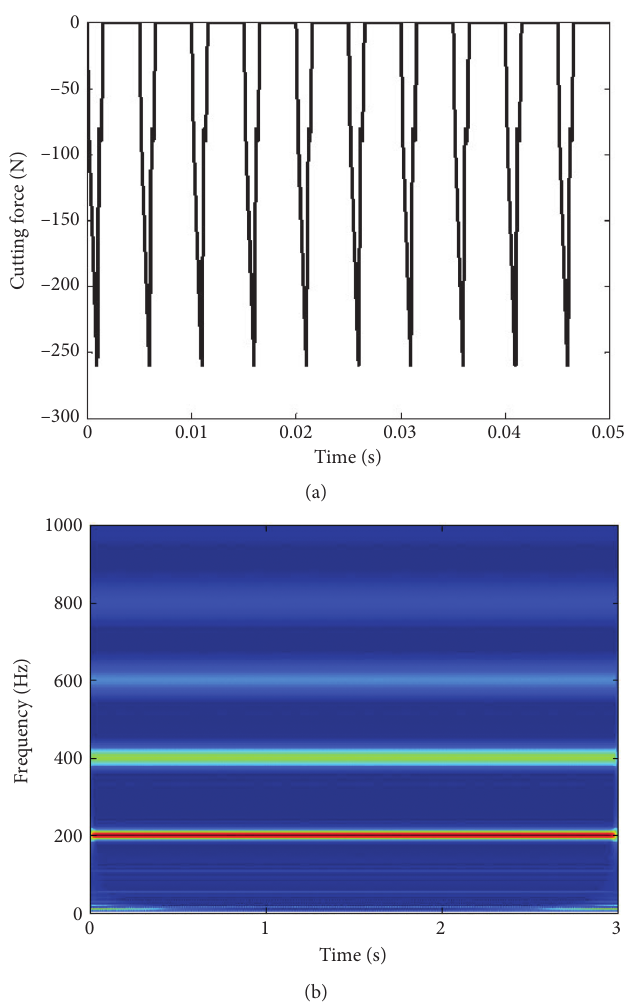
Figure 6: (a) Cutting force. (b) Wavelet transform of